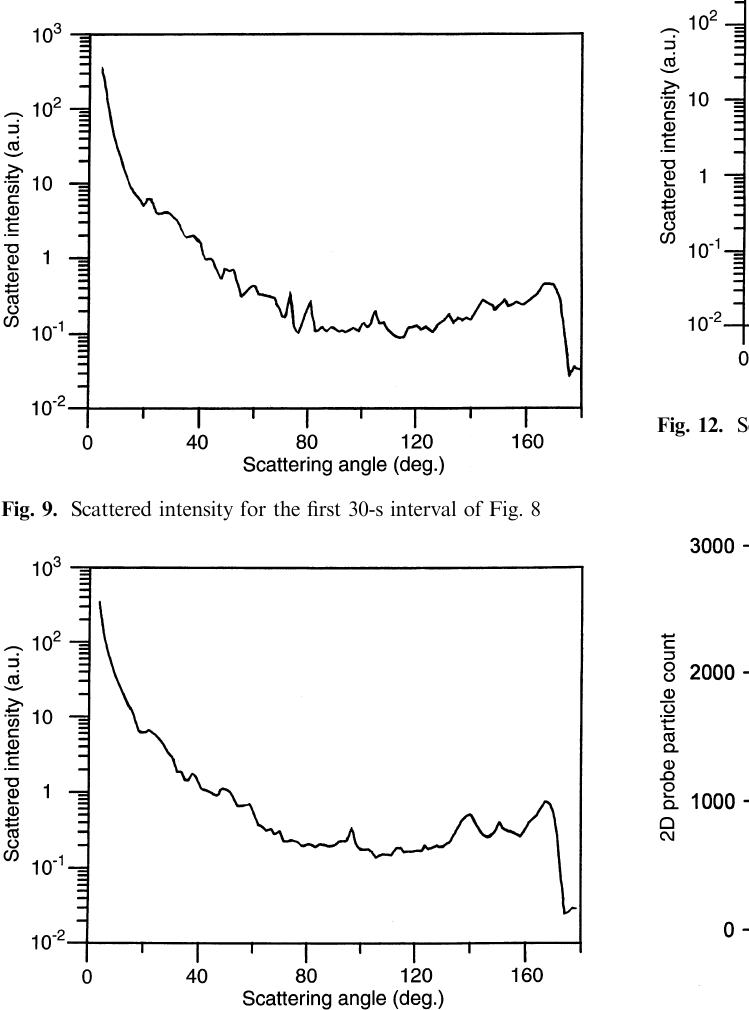
Fig. 10. Scattered intensity for the second 30-s interval of Fig. 8